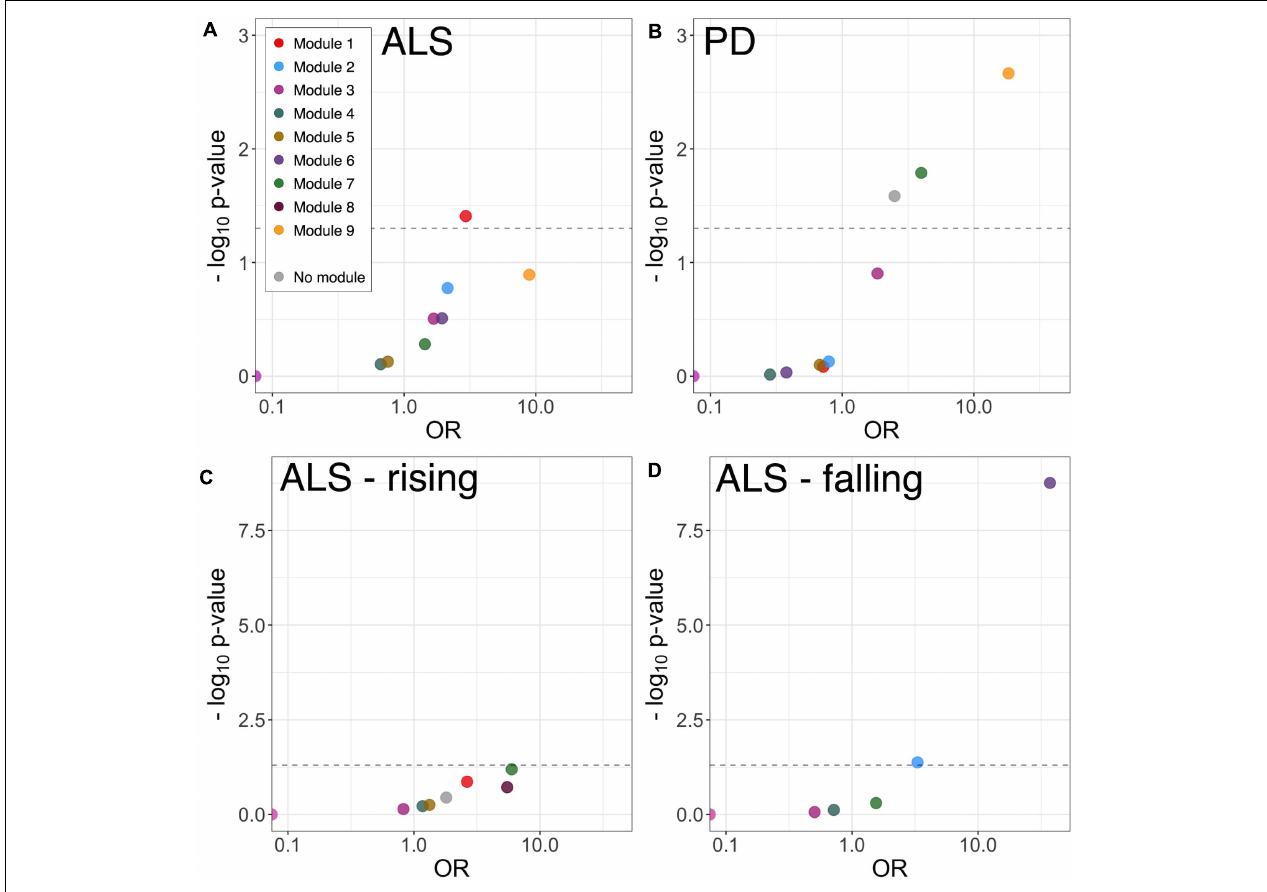
FIGURE 4 | Module enrichment of differentially correlated proteins in ALS (A) and PD (B) , and longitudinally falling (C) or rising (D) proteins in ALS. ALS, amyotrophic lateral sclerosis; PD, Parkinson’s disease.